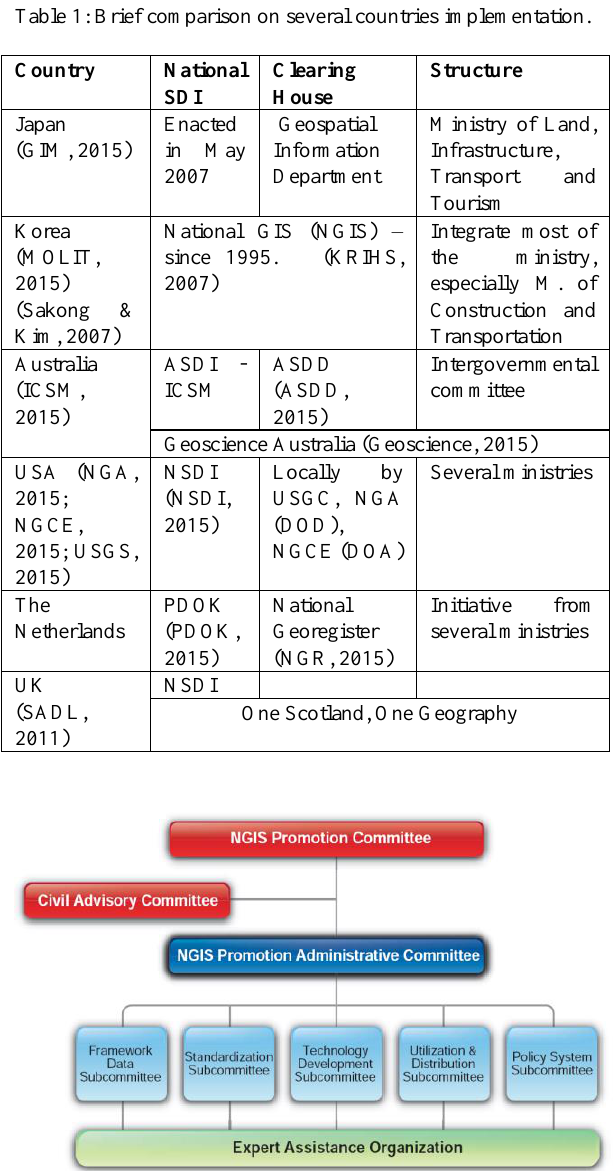
Table 1: Brief comparison on several countries implementation.